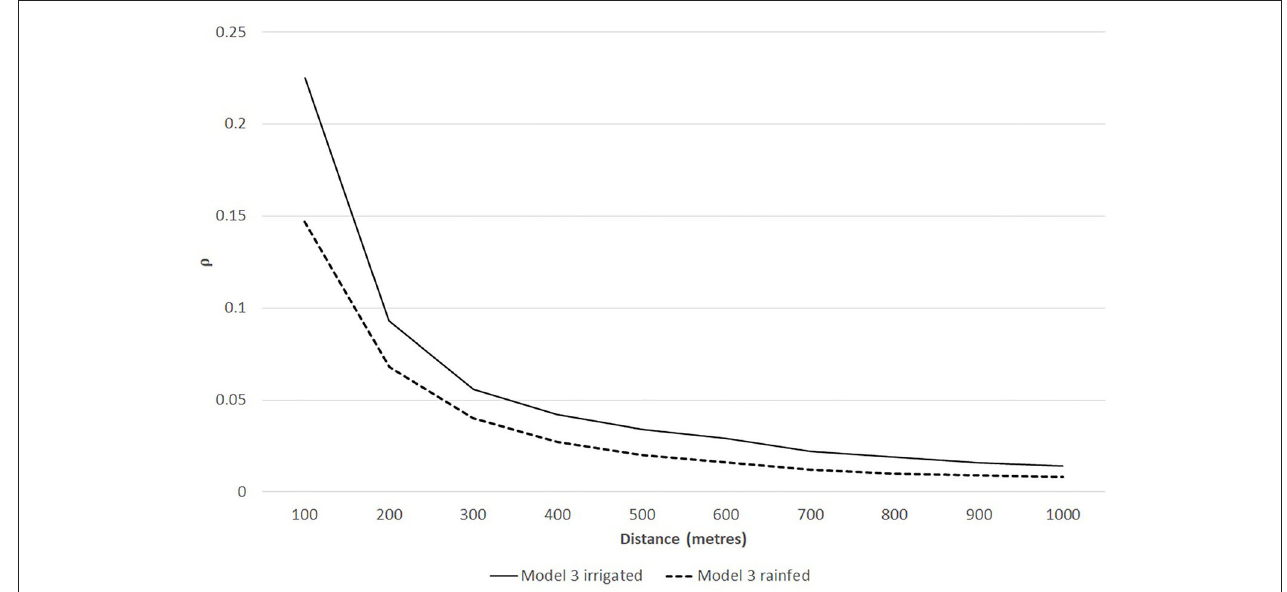
FIGURE 2 | Spatial dependence at different cut-off distances for model 3 in irrigated farms and rainfed farms.